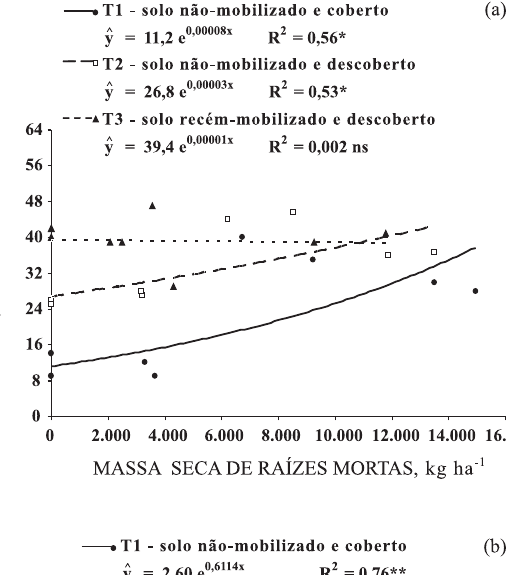
Na figura 4, são apresentados os resultados da